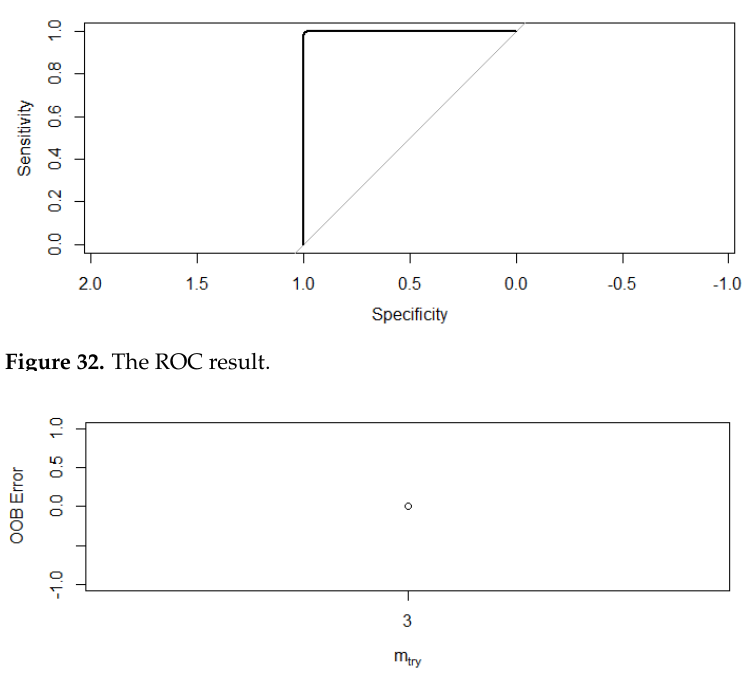
Figure 33. The best mtry